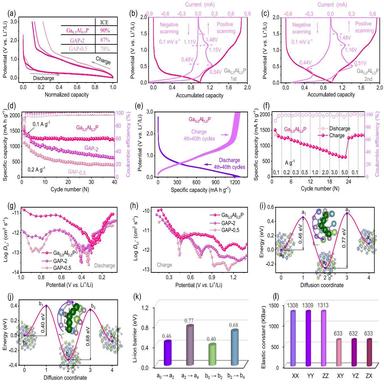
(a) First galvanostatic charge and discharge (GCD) profiles and initial Coulombic efficiency (ICE) of the Ga0.5Al0.5P and pre-determined GAP-x samples. CV curves coupled with the corresponding GCD profiles: (b) first cycle; (c) second cycle. (d) Cycle performance and (e) GCD curves of as-prepared Ga0.5Al0.5P at 0.2 A/g. (f) Rate performance. Li-ionic diffusion coefficients of the Ga0.5Al0.5P and pre-determined GAP-x samples: (g) discharge process; (h) charge process. (i and j) Li-ionic diffusion paths and c